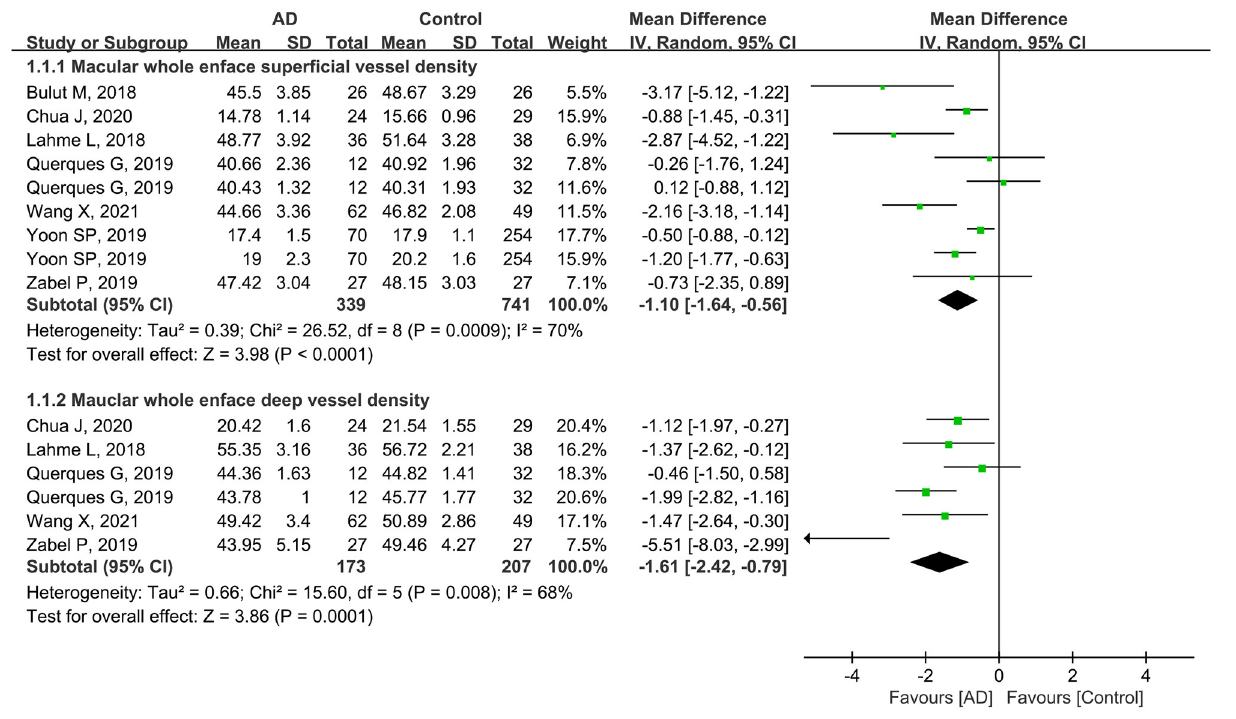
patients with AD with mild heterogeneity across studies (chi 2 = 4.06, P = 0.13, I 2 = 51%, Figure 6 ). In addition, the parafoveal deep VD (3 × 3-mm scan) was also substantially reduced in eyes with AD (MD: − 1.09, P = 0.03, Figure 6 ), with the studies